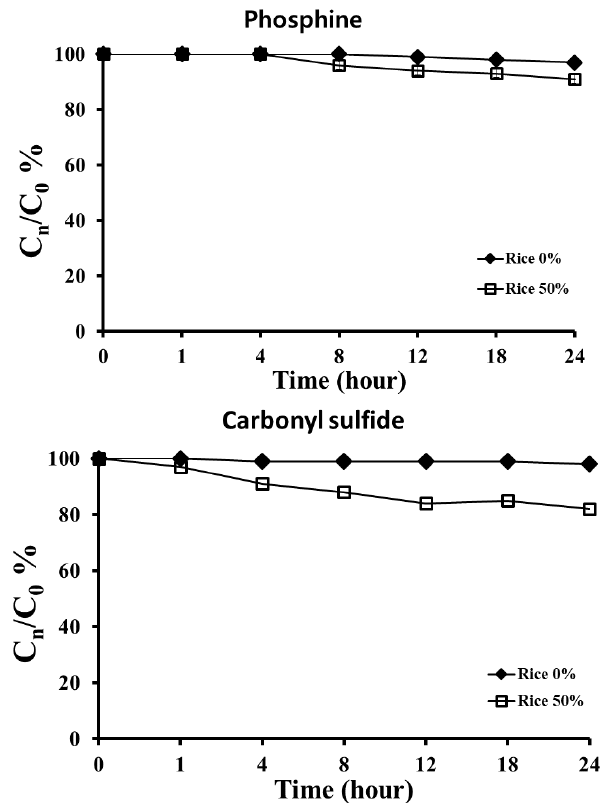
Figure 4. Concentrations of the two fumigants (2 mg/L PH 3 and 50 mg/L COS) at 20 °C according to the loading ratio (0% and 50%) of rice for 24 h in a 12-L desiccator.